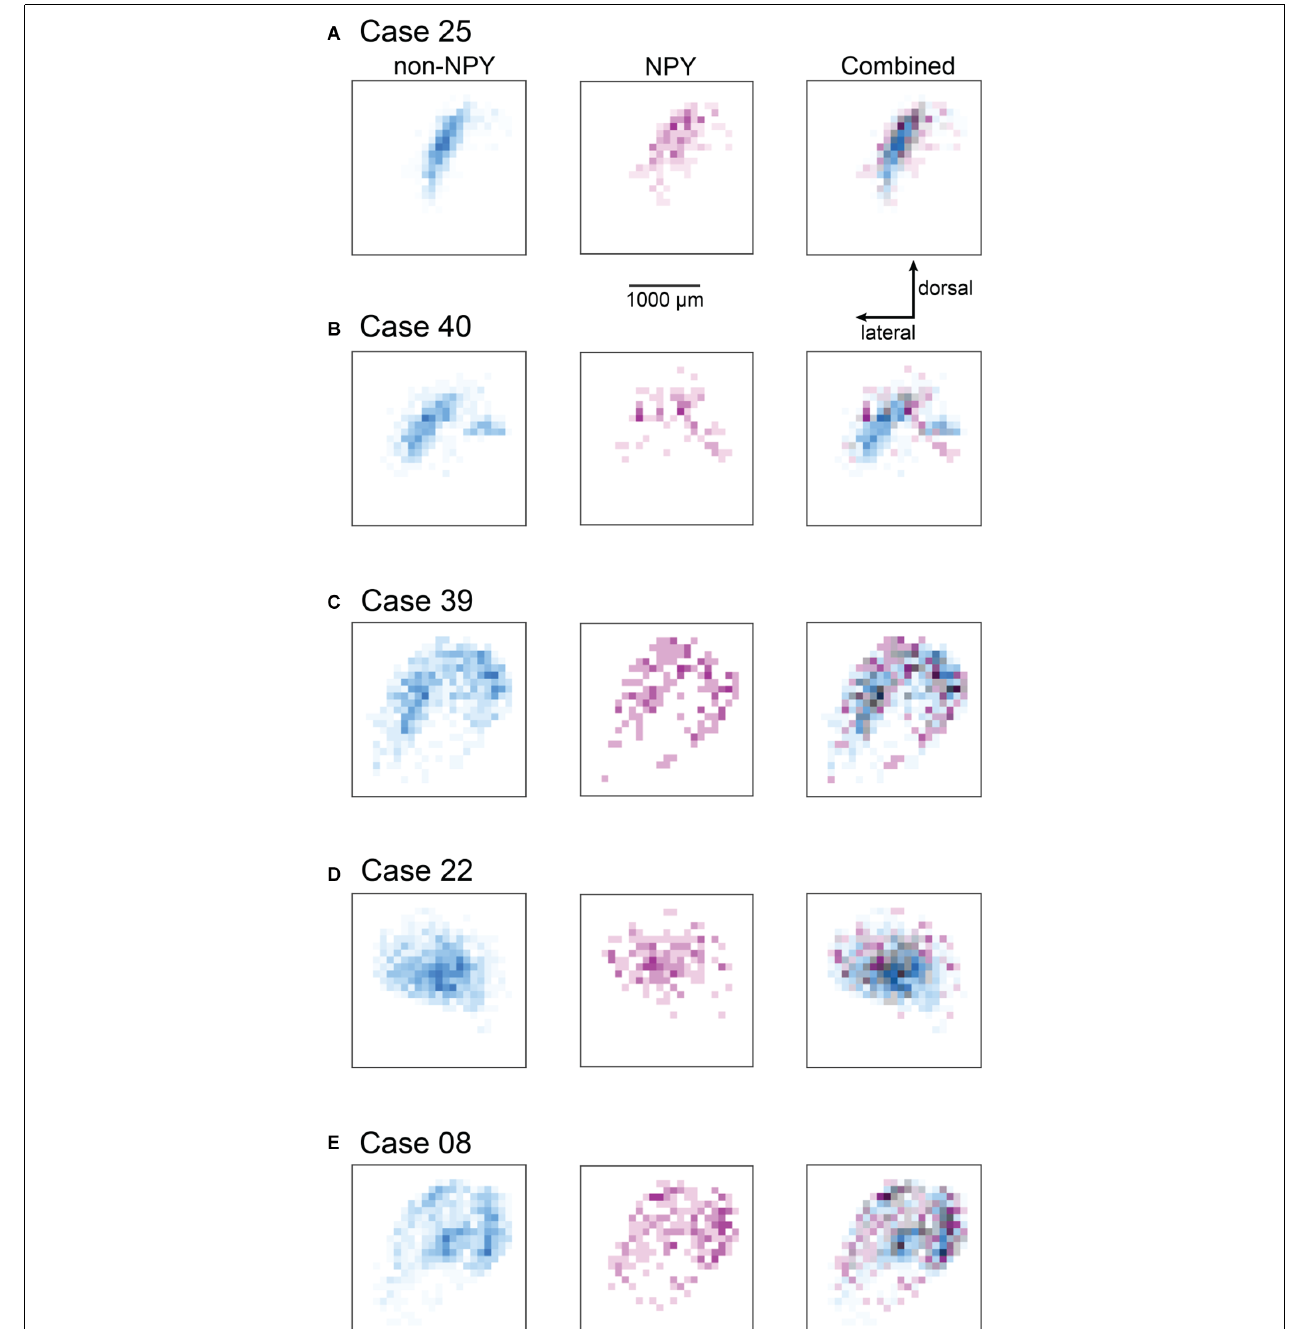
FIGURE 5 | Heatmaps showing the distribution of RB-labeled neurons across all IC subdivisions for the ICc injection cases. Heatmaps were prepared as for Figure 4 , except that all RB-labeled neurons in the IC were included in the analysis. The scale bar and dorsal and lateral direction arrows in (A) also apply to (B–E) . The heatmap bins corresponding to the ICc appear nearly identical to the patterns observed in Figure 4 , where only ICc neurons were analyzed. The cases shown in (A,B,D) also show little overlap between NPY and non-NPY neurons in the regions beyond the ICc, while the cases in (C,E) show a higher degree of overlap in the regions surrounding the